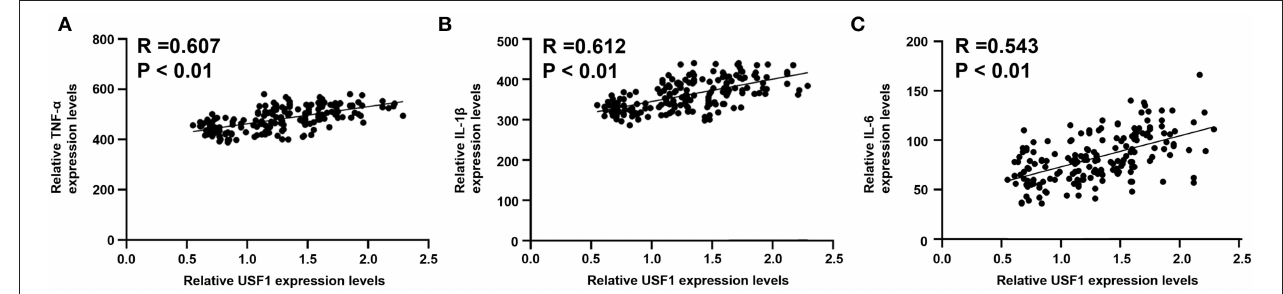
FIGURE 6 | Correlations between USF1 mRNA expression and serum TNF- α , IL-1 β , and IL-6 levels. (A) TNF- α levels were positively correlated with the USF1 mRNA expression levels. (B) IL-1 β levels were positively correlated with the USF1 mRNA expression levels. (C) IL-6 levels were positively correlated with the USF1 mRNA expression levels. USF1 , upstream transcription factor 1; TNF- α , tumor necrosis factor- α ; IL-1 β , interleukin 1 β ; IL-6, interleukin 6.